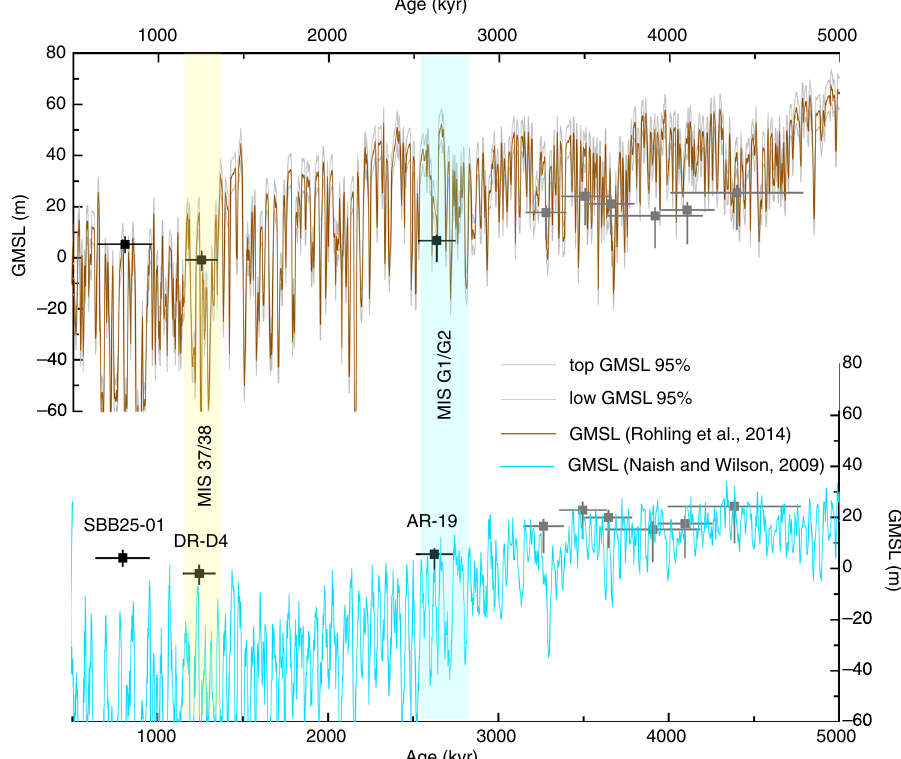
Figure 3. Pliocene and Pleistocene global mean sea level estimates. POS-derived Pliocen and Pleistocene GMSL are indicated by silver 34 and black (this study) markers, respectively (age uncertainties are 2σ; the GMSL of the marker corresponds to the mode and the error bars to the 16th and 84th percentiles). Thermal expansion correction is not applied for any of these estimates. Brown and cyan curves show two oxygen isotope based sea level reconstructions (brown is the GMSL derived estimates from the planktonic foraminifera and the marginal basin residence time 24 and cyan is the GMSL curve derived from the conversion of LR04 benthic foraminiferal δ 18 O stack by scaling with a calibration of 0.011 ppt m −1 as in 23